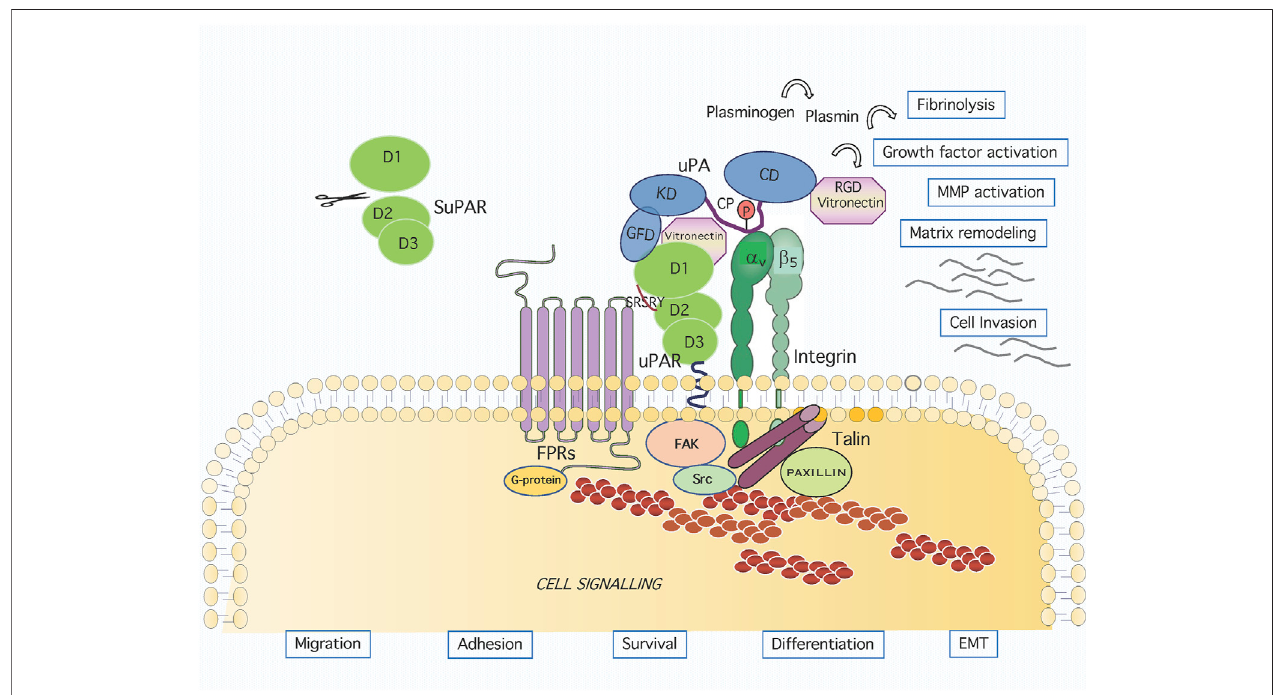
FIGURE 1 | Graphic representation of the uPAR system on cell surface. Active urokinase (uPA) catalyses the conversion of the inactive zymogen plasminogen to the active proteinase plasmin, which can degrade most extracellular matrix proteins. The uPAdomainsare represented asthe growth factor-like domain (GFD, residues 1 – 49), the kringle domain (KD, residues 50 – 131), the interdomain linker or “ connecting peptide ” (CP, residues 132 – 158), and the serine protease domain (CD, residues 159 – 411). The uPA interacts with the GPI-anchored urokinase receptor (uPAR) through GFD and with integrin through CP, bridging the two receptors together. TheuPARconsistsofthreehomologousdomainsdenotedD1(residues1 – 92),D2(residues93 – 191)andD3(residues192 – 283).TheuPAR/integrininteractionresultsin the regulation of focal contacts turnover. Association and signalling through formyl peptide receptors (FPRs) involves the chemotactic SRSRY uPAR sequence. Membrane proximally interactions result in intracellular signaling and the regulation of migration, adhesion, survival, differentiation and EMT.